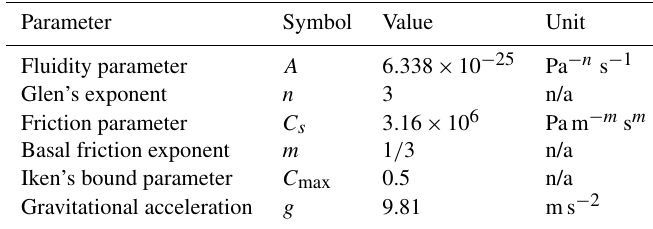
Table A1. Parameters of Glen’s flow law and Schoof friction law. n/a – not